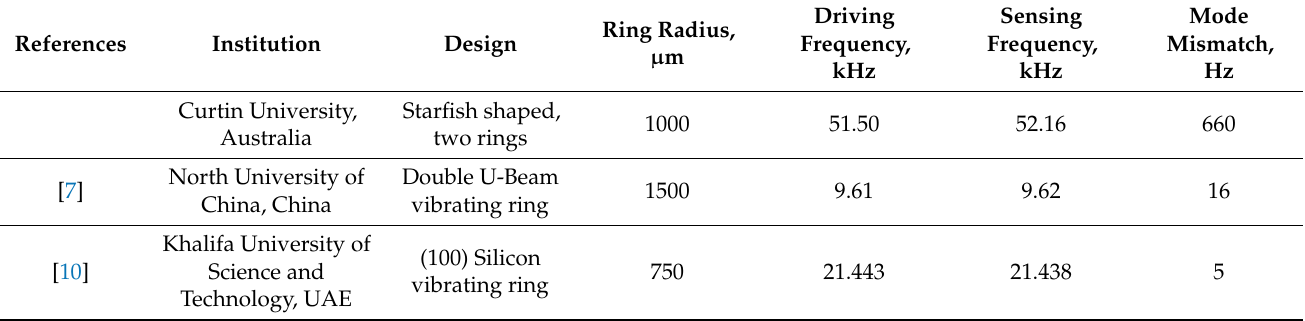
Table 2. Comparison with similar vibrating ring gyroscope designs.